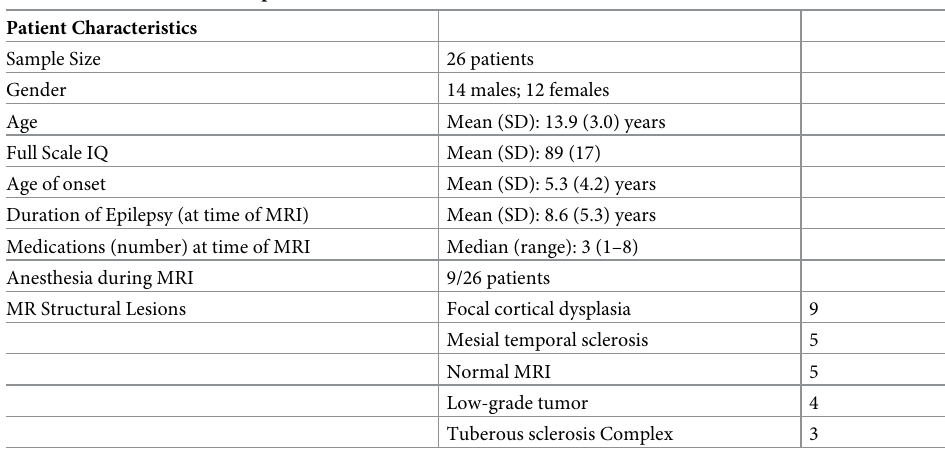
Table 2. Characteristics of the patient